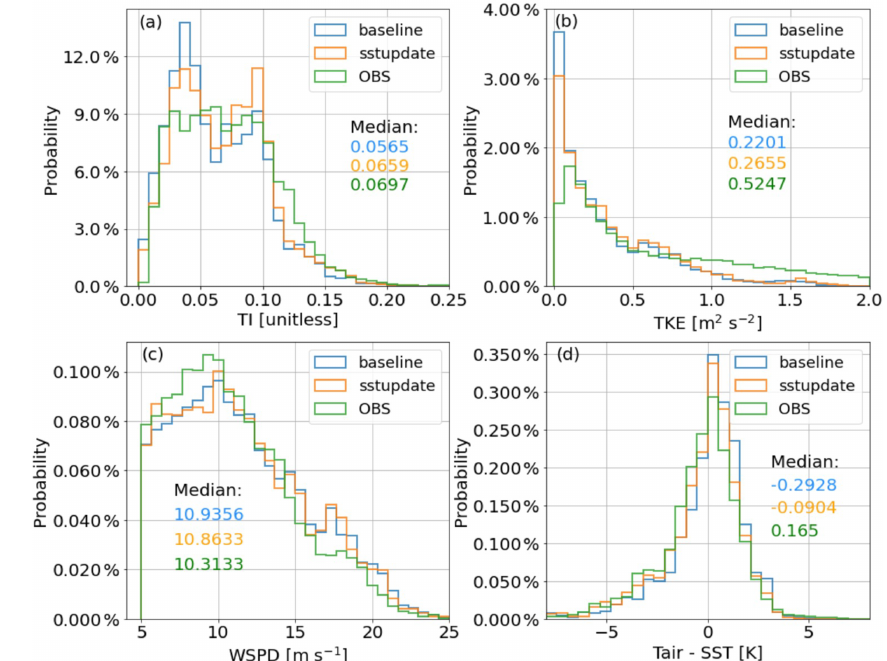
Figure 7. Probability density function (PDF) plots illustrating the results of (a) sub-grid turbulence intensity (TI), (b) turbulence kinetic energy (TKE), (c) wind speed (WSPD), and (d) air–sea temperature difference among baseline, sstupdate simulations, and observations at hub height ( ∼ 80m) from February to May of 2020. The color-coded median of each dataset is given in each